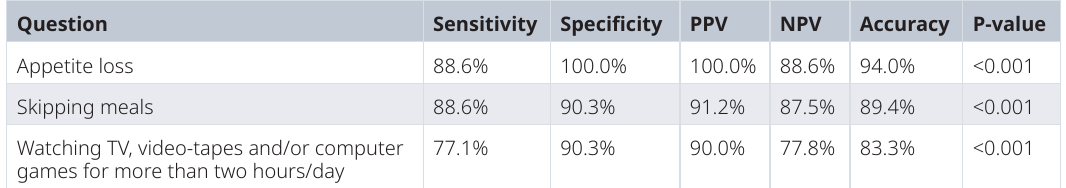
Table 7. Development of the valid and simple nutritional screening tool during the early childhood group.